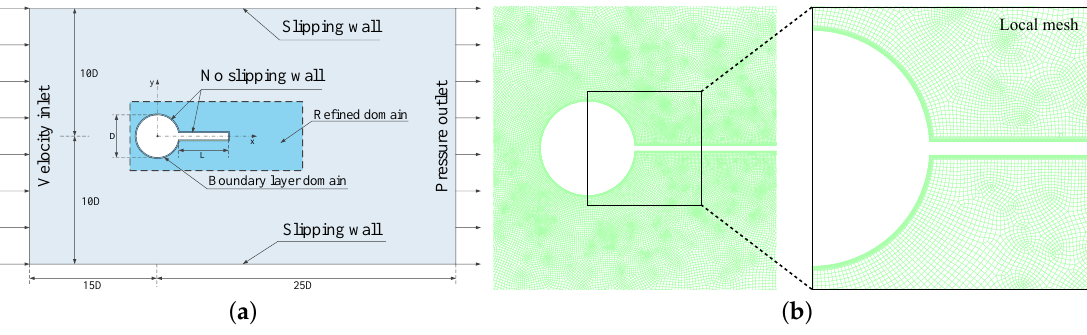
Figure 2. ( a ) Computation domains and boundary conditions; ( b ) computing mesh and a local detail